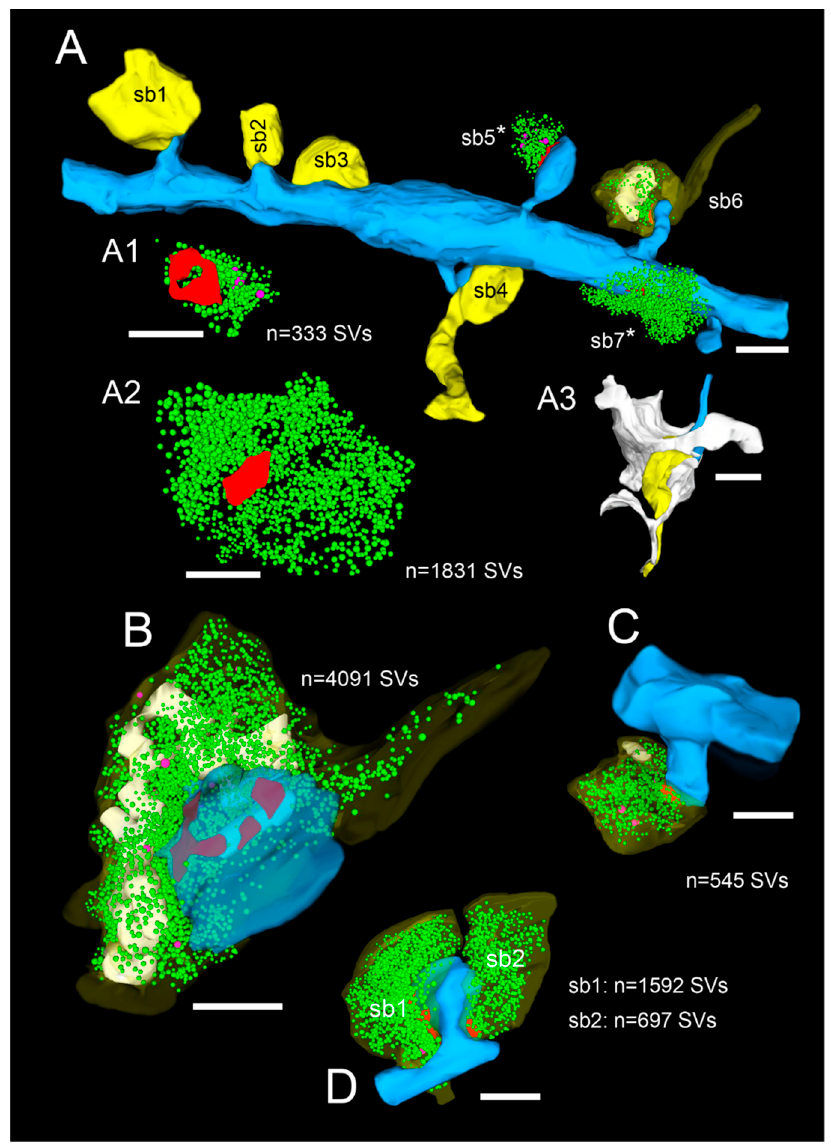
Figure 7. 3D-volume reconstructions of SBs and their target structures in the human TLN 3D reconstructed from FIB-SEM and TEM z-stacks. ( A ), Dendritic segment (blue) in L2 receiving dense synaptic input by seven SBs (yellow, sb1–sb7) reconstructed from a large z-stack using FIB-SEM. In two SBs, the bouton cover was omitted, and in one, it was made transparent to allow the visualization of the total pool of SVs (green dots), the AZ (red), and mitochondria (white). Note the different shape and size of the synaptic terminals and the content of SVs. ( A1 ), ( A2 ), ( 3D )—reconstruction of the total pool of SVs in the spine (sb5) and shaft (sb7) SB shown in A as marked by asterisks. Note the large difference in the pool of SVs and the lack of mitochondria in the large shaft bouton. ( A3 ), Representative example of the dense astrocytic ensheathment (white contour) of an axo-spinous synaptic complex. The astrocytic coverage isolates the synaptic complex from the neuropil and other synaptic complexes, and fine astrocytic processes can be followed to reach the synaptic cleft. ( B – D ), Three representative examples of SBs and their target structures 3D reconstructed based on serial ultrathin sections and TEM imaging. All SBs are given in their proportional size to each other. ( B ), Large end terminal SB in L2. Here, the cover of the SB and that of the postsynaptic spine was made transparent yellow and blue to visualize the pool of SVs (green dots), mitochondria (white), and the three AZs (red) in the presynaptic terminal. ( C ), SB with a comparably small pool of SVs terminating on a stubby spine in L2. ( D ), Two SBs (sb1, sb2) terminating on the same mushroom spine in L2. Note the different geometry and size of SBs, the different number, shape, and size of the AZs, the pool of SVs, and the content or lack of mitochondria. Scale bar in ( A – D ), 0.5 µm.